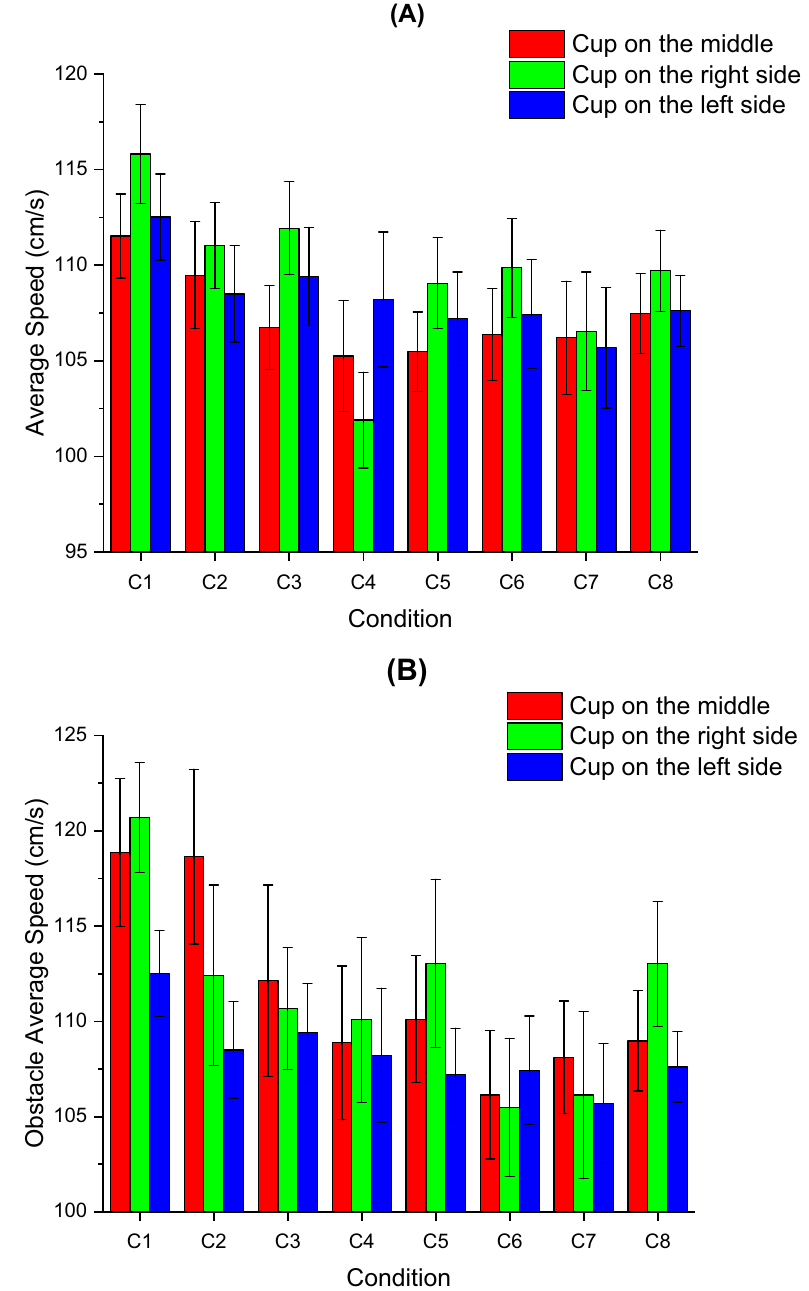
Figure 5. Average speed as a function of target location and obstacle condition. ( A ) Average velocity from the start location to bookcase ( B ) Average speed from the start location to the obstacle area. The obstacle conditions are C1: Condition 1 (NOBST), C2: Condition 2 (AM-R80/AM-L80), C3: Condition 3 (AM-L61/R61), C4: Condition 4 (AM-L84/R40), C5: Condition 5 (AM-L40/R84), C6: Condition 6 (AM-L39/R39), C7: Condition 7 (AM-L52/R25), C8: Condition 8 (AM-L25/R52). Error bars indicate